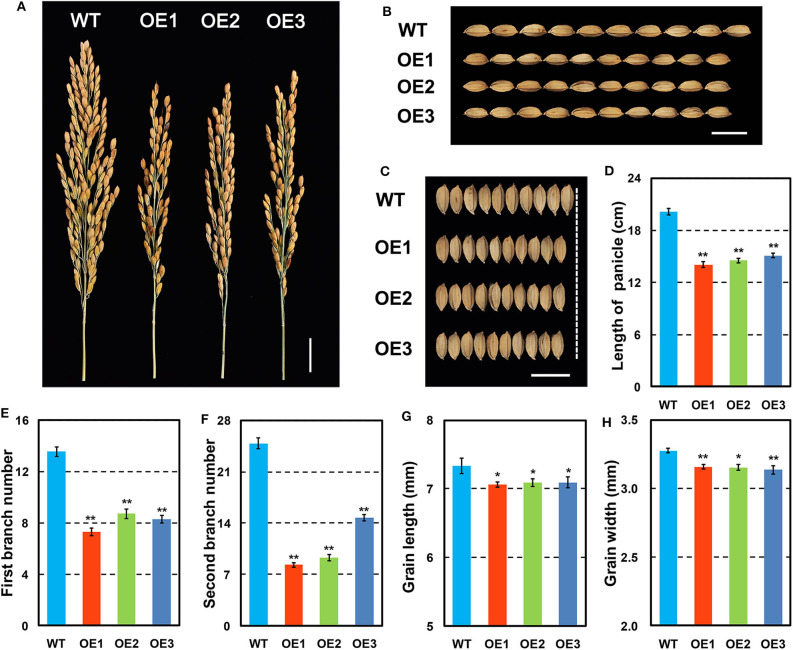
Detailed panicle and grain features of OsCKX2 OE rice and WT. Phenotypes of panicles (A), and grains (B,C). Statistical analysis of length of panicle (D), first branch number (E), second branch number (F), grain length (G), and grain width (H). Data represents means ± SEM (n = 15). **P < 0.01, *P < 0.05. Scale bars: 2 cm (A), 1 cm (B,C).